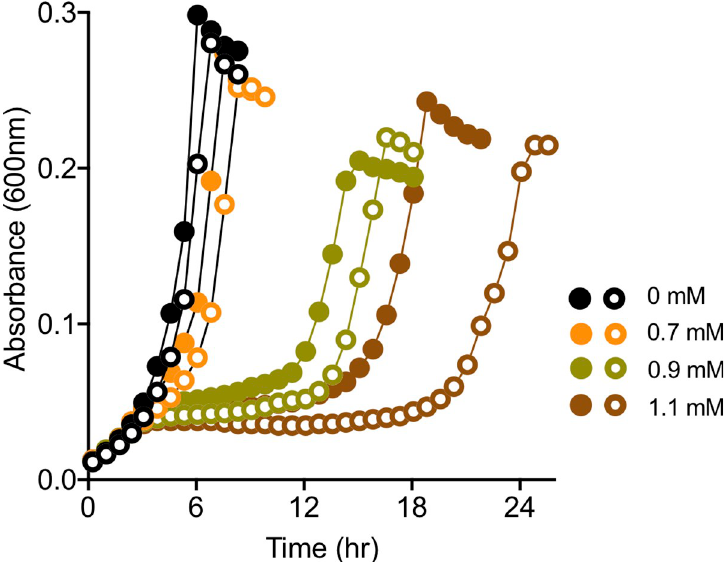
Fig 11. EfgA provides protection to E . coli strains during formaldehyde exposure. Growth of E . coli was quantified in liquid MOPS medium with 2 mM glucose and 0, 0.7, 0.9, or 1.1 mM exogenous formaldehyde added after 2.33 h. Strain WM8637 (filled symbols) harboring a chromosomal insert of efgA under the control of P rhaS or the empty vector control (WM8653, empty symbols) was grown in comparable conditions. efgA expression was induced with 0.5 mM rhamnose. Data are representative of trends observed in multiple experiments. The original data shown in this and all other figures are available in Supporting information file S1 Data.